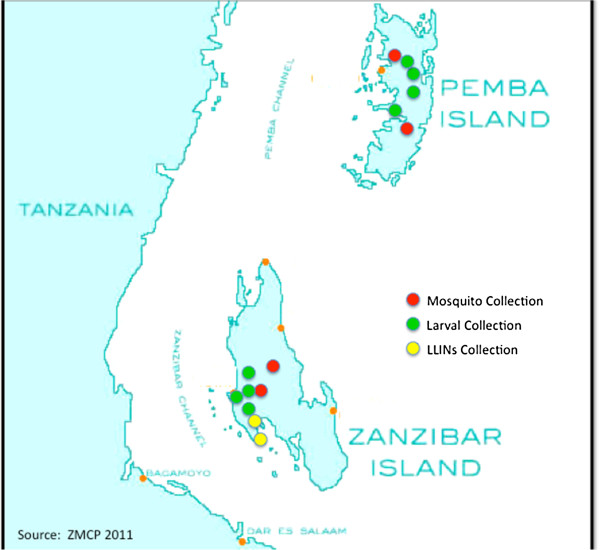
Map of the Zanzibar islands showing collection areas.